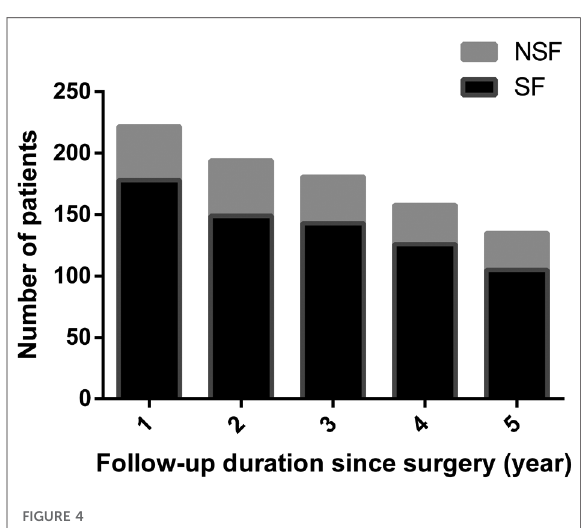
FIGURE 4 Seizure outcomes according to follow-up duration since